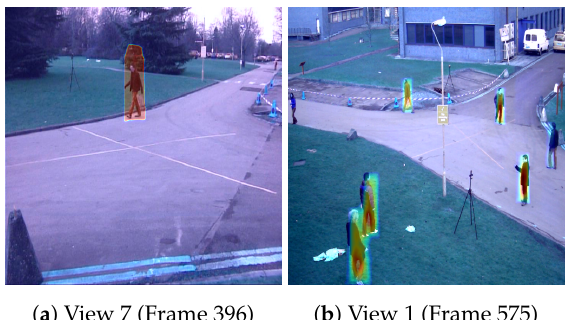
Figure 6. The activation of layer Conv2d_27 achieved through Grad-CAM [43]. It is the 2nd last layer in the decoder network and shows the maximum response of the network on the middle frame given the three input